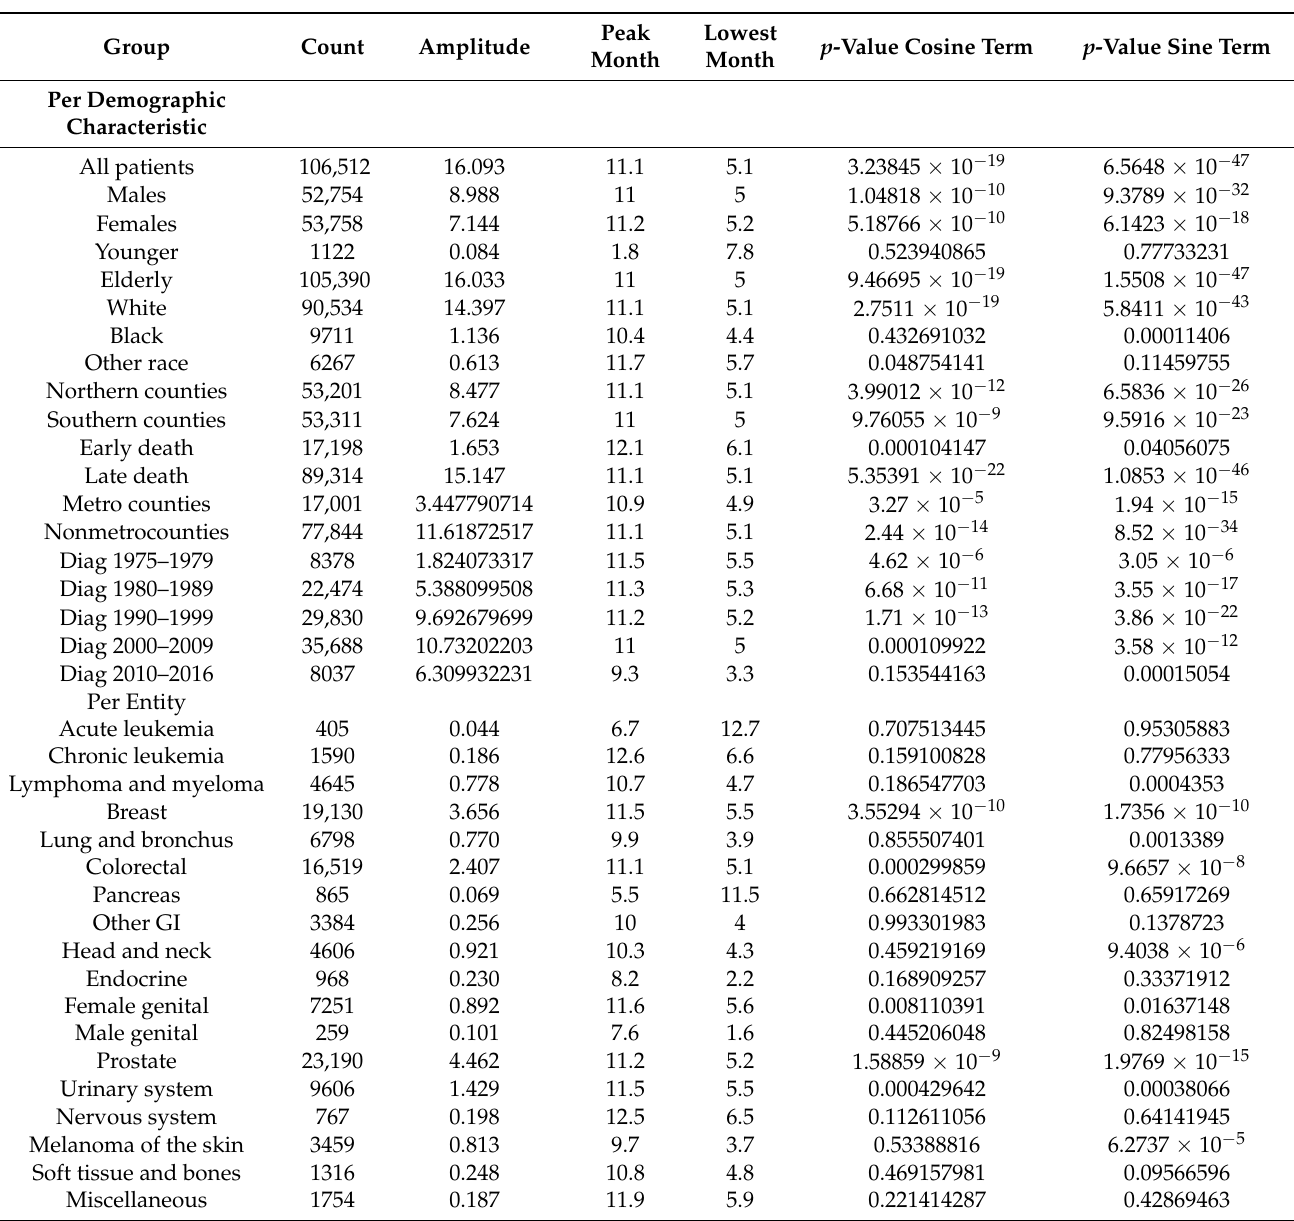
Table 2. Parameters of the cosinor model fits to all cancer patients with death from cerebrovascular disease and defined